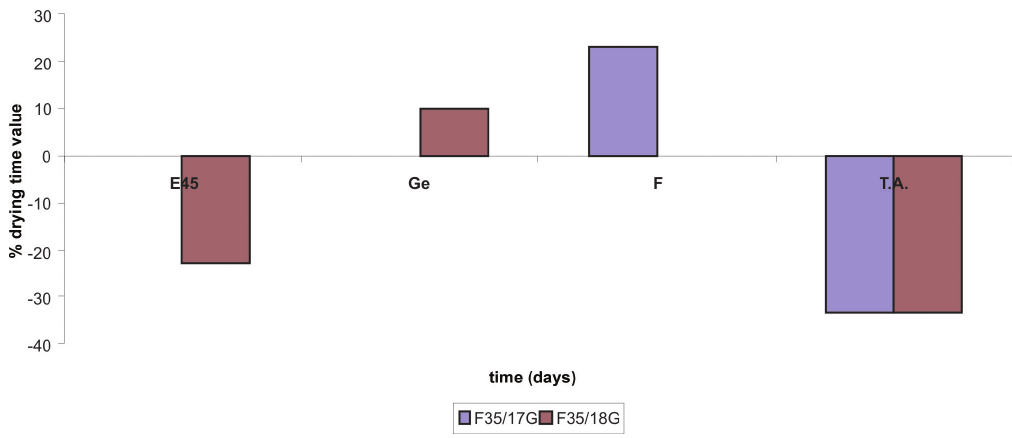
FIGURE 8 - Percentage variation of in vitro drying time for the test formulations F35/18 and F35/17G in the Oven (E45/45.0 ± 2.0 ºC), Refrigerator (Ge/5.0 ± 1.0 °C), Freezer (F/-10.0 ± 1.0 °C) and Room Temperature (TA/22.0 ± 2.0 °C) storage